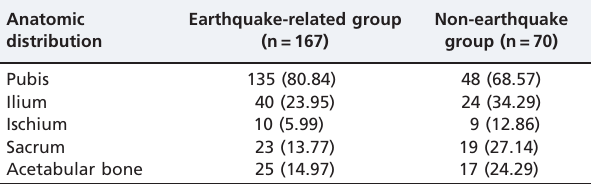
Table 2- Patients with pelvic fractures according to each pelvic bone involved.